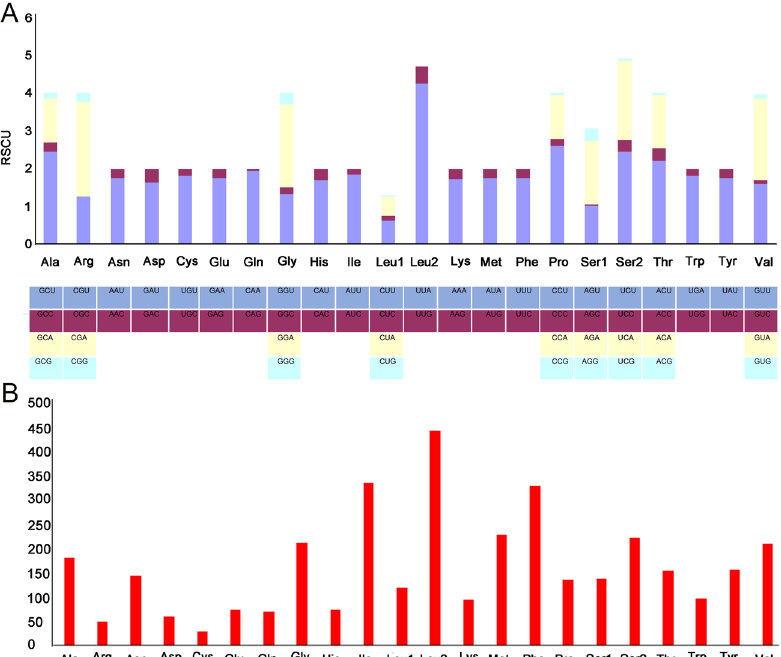
Figure 2. Relative synonymous codon usage in Clistocoeloma sinensis mtDNAs. Codon families are provided on the x axis ( A ). ( B ) Nucleotide composition conditions.